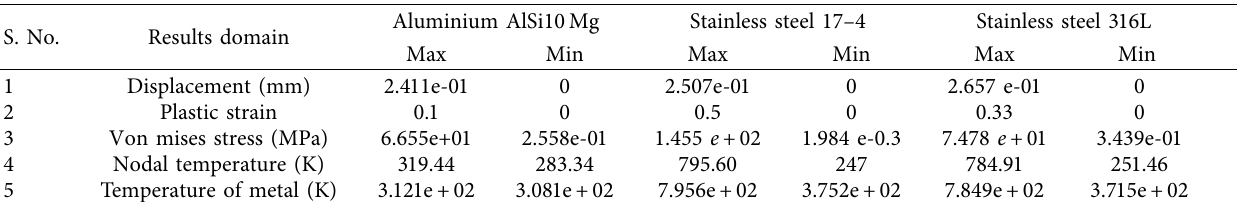
Table 8: Simulation results For the Rank 10 position.